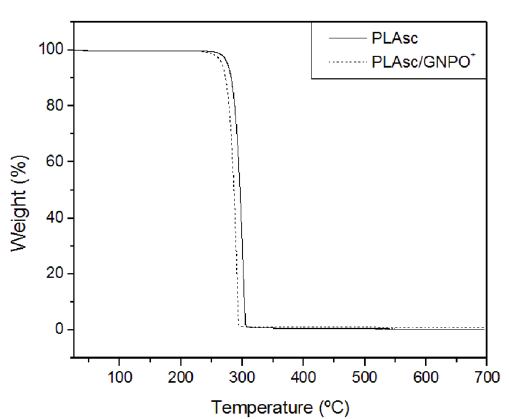
Figure 2. TGA curves of scPLA and scPLA/GNPO+ nanocomposite.